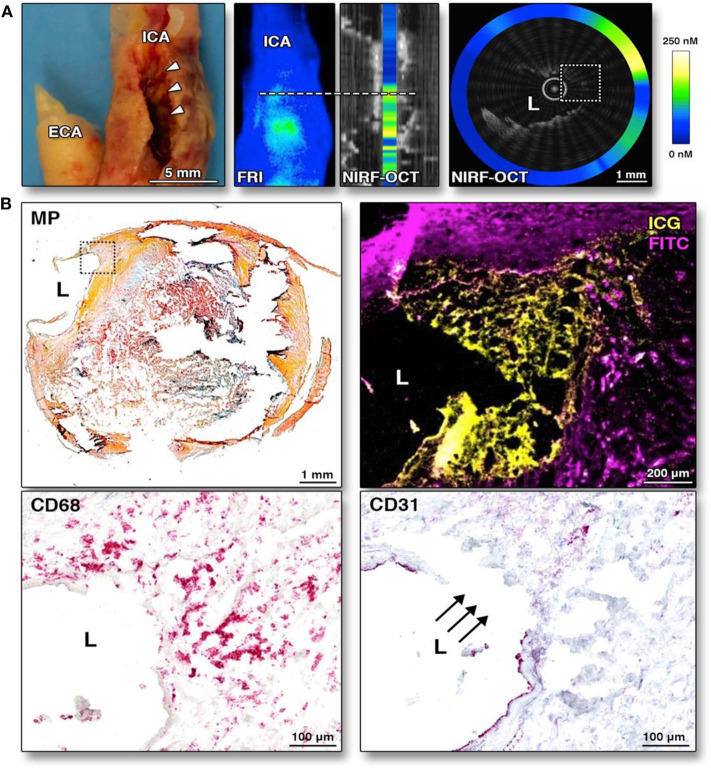
Ex-vivo intravascular NIRF-OCT images of human carotid arteries following ICG injection and then endartectomy. ICG was injected into human subjects 99 min prior to endartectomy. ICG accumulates in atherosclerotic area especially endothelial discontinuation. (A) Corresponding gross internal carotid artery (ICA) specimen, along with corresponding fluorescence reflectance image (FRI), and NIRF-OCT cross sectional, coregistered images, illustrating similar ICG uptake pattern (light blue = low ICG signal; green-yellow = high ICG signal) at the stenotic region (white arrowheads) in the ICA. (B) Histological analysis of the same area of the NIRF-OCT cross-sectional image shown in (A). Movat pentachrome (MP) shows a complex atherosclerotic plaque with a large necrotic core with lipid and cellular infiltration (dotted box). Higher magnification (10×) fluorescence microscopy of the boxed area illustrates ICG NIRF signal adjacent to the lumen, which is distinct from fluorescein isothiocyanate (FITC)-channel autofluorescence. CD68 staining of the same area validates that the ICG NIRF signal (yellow pseudocolor) spatially relates to CD68-defined plaque macrophages beneath the area of intimal disruption. The disruption is confirmed by CD31 staining in this same area. ECA, external carotid artery. Verjans et al. (81), by permission of American College of Cardiology (ACC). License number: 4720551416574.